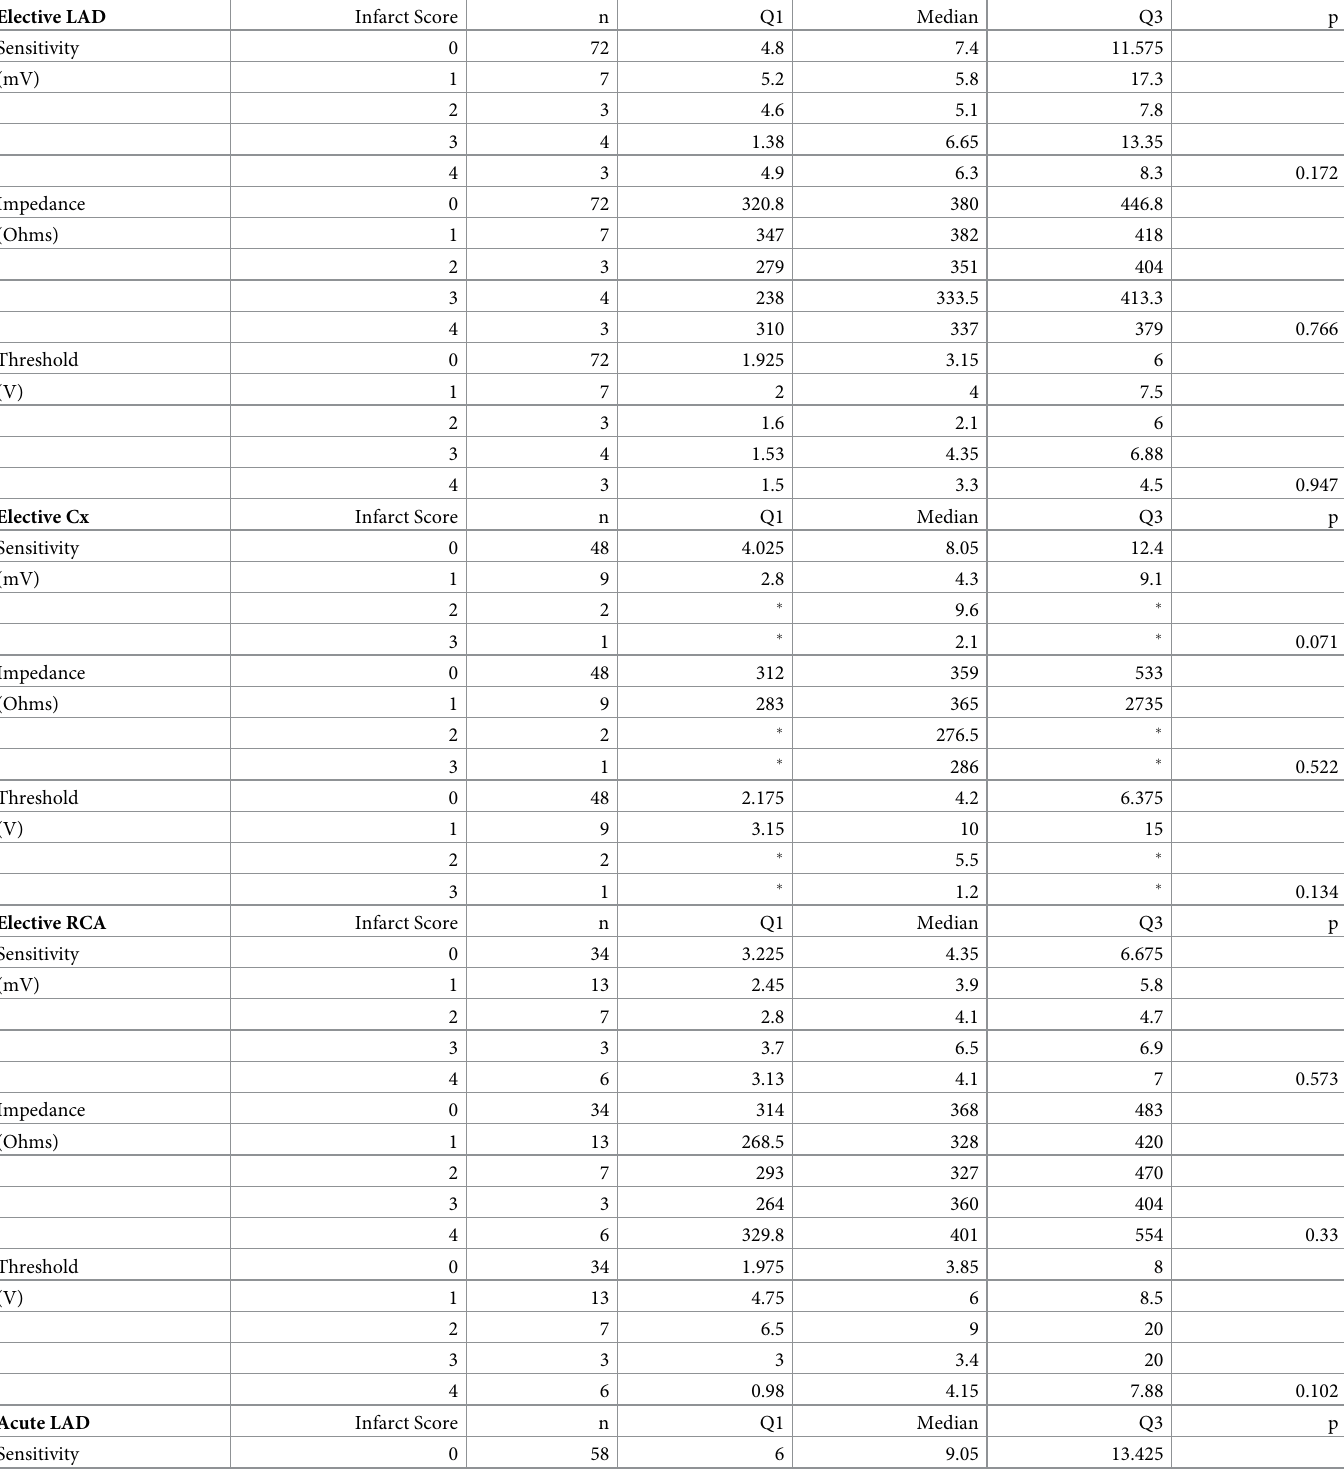
Table 3. A. CMR infarct score and respective electrophysiological parameters in segments assessed during elective coronary angiography for stable angina. B. CMR infarct score and respective electrophysiological parameters in segments assessed during acute coronary angiography following NSTEMI. Elective LAD Infarct